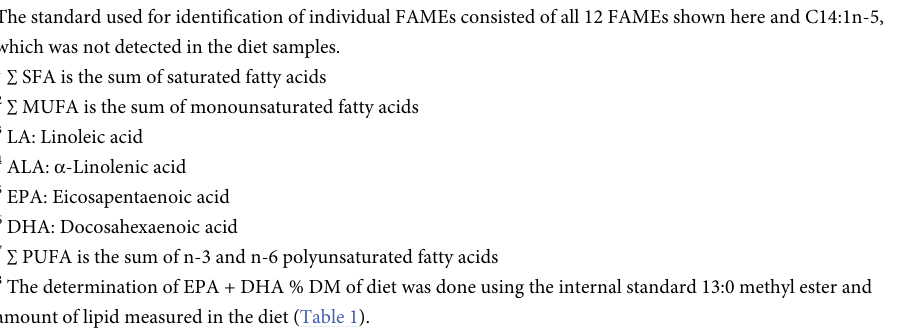
The standard used for identification of individual FAMEs consisted of all 12 FAMEs shown here and C14:1n-5, which was not detected in the diet samples.